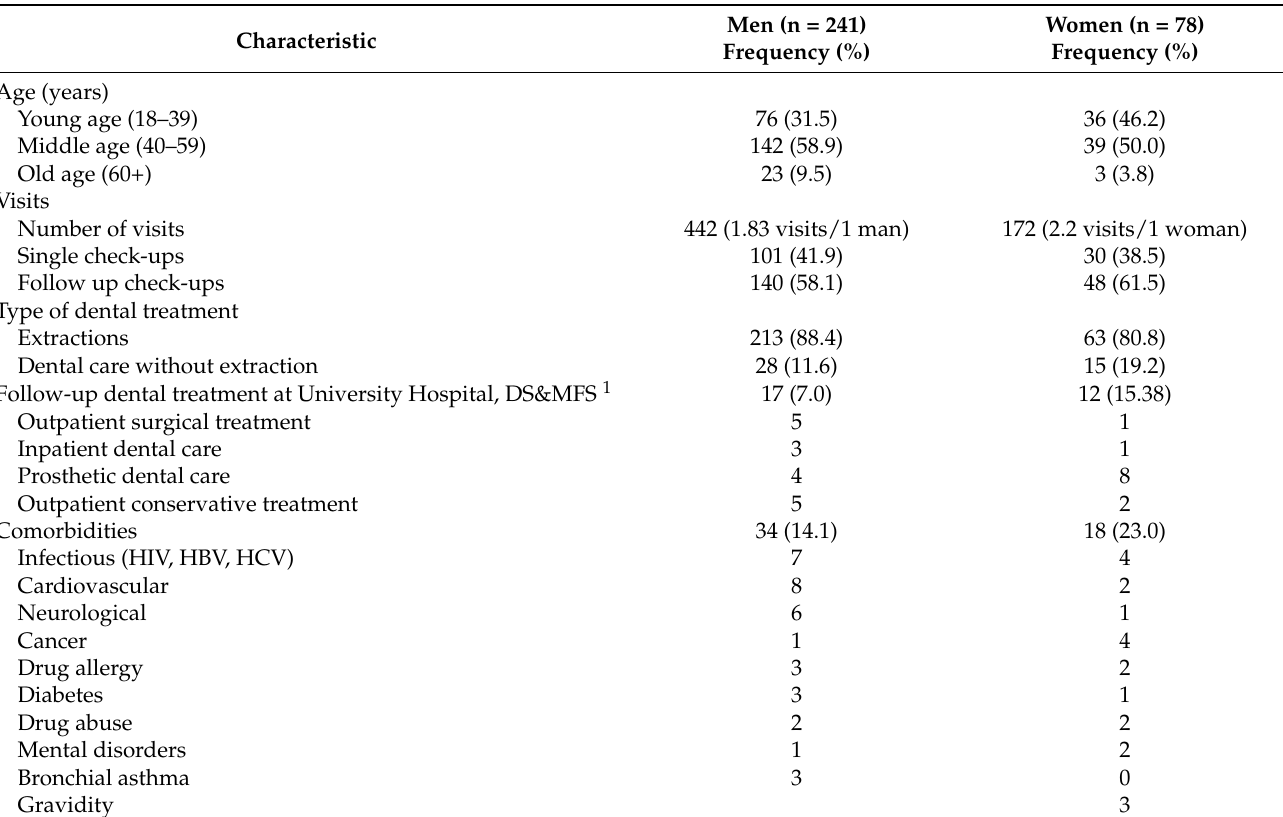
Table 1. Characteristics of patients (homeless people, n = 319) and type of dental services use stratified by gender in Bratislava, Slovakia,